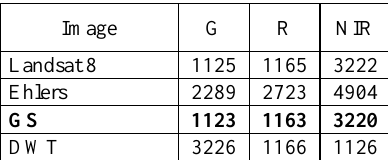
Table 5. Spectral discrepancy between Ehlers, DWT and GS fusion results according to three selected bands for analysis (green, red and near-infrared).